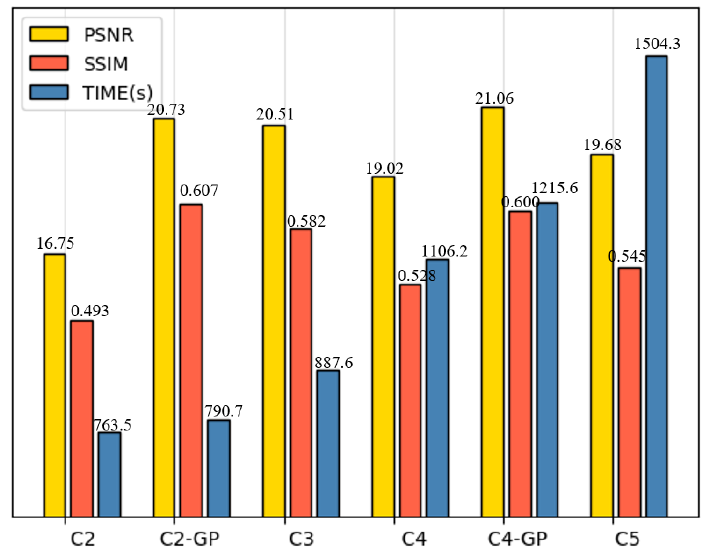
Figure 12. The results of changing the convolution kernel and padding method under SNR = − 10 dB.